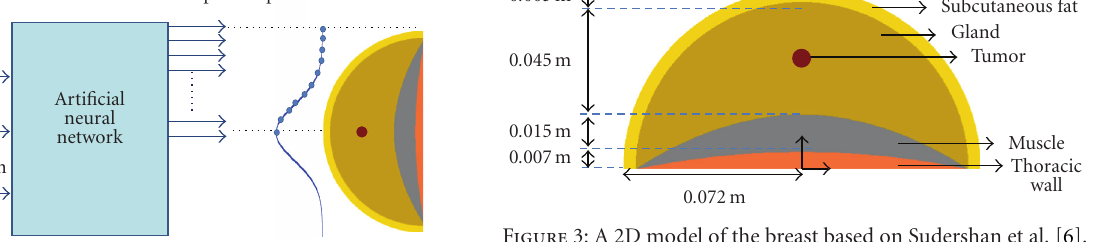
Figure 3: A 2D model of the breast based on Sudershan et al.